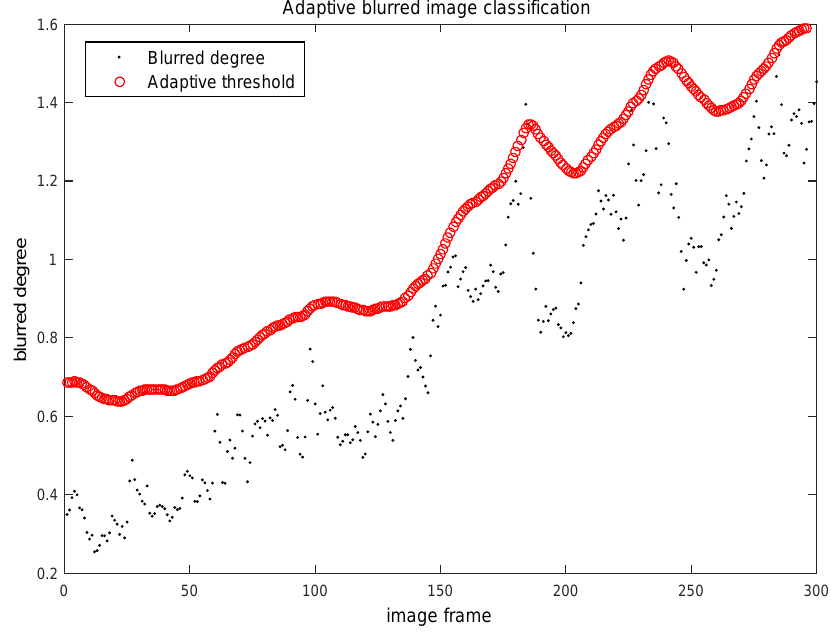
Figure 8. Blurred image classification results on the original NewCollege